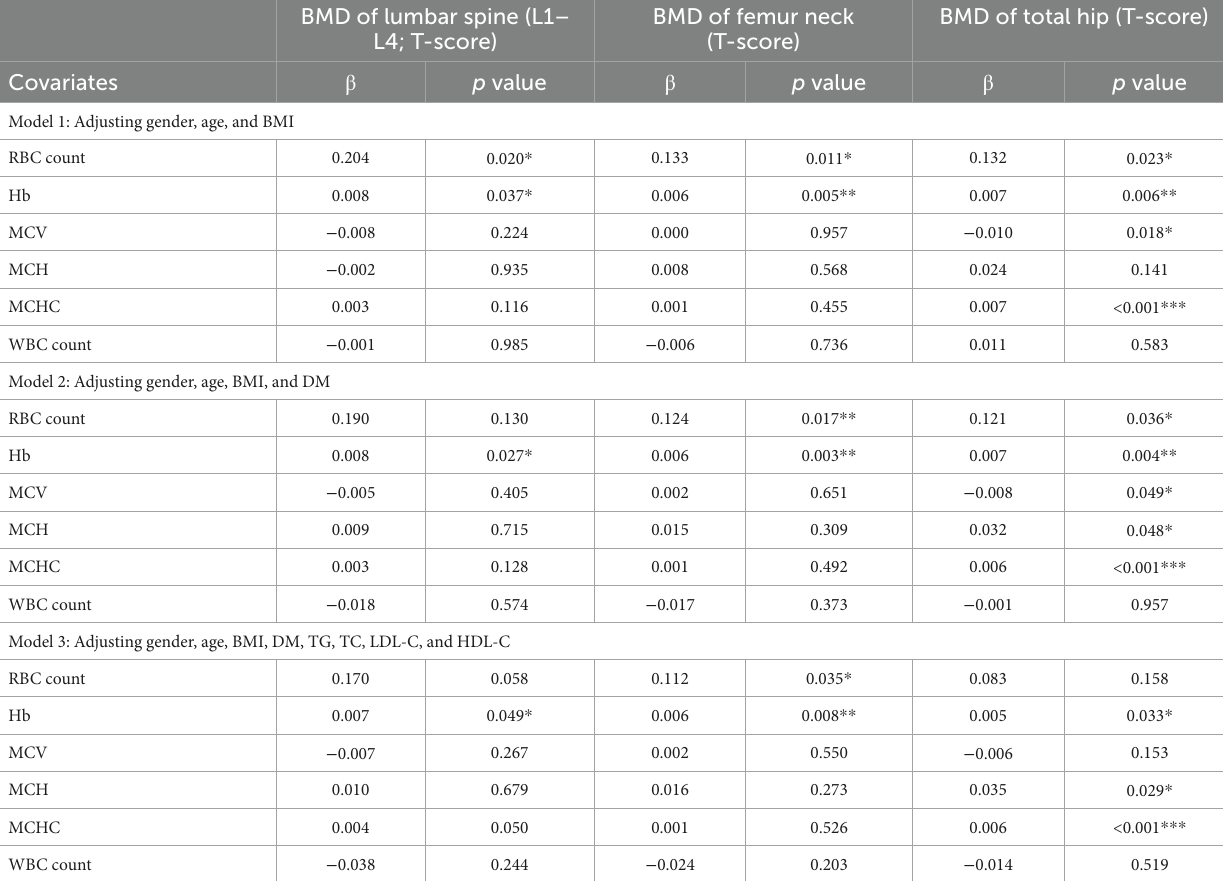
TABLE 3 Correlation between blood indices and BMD T-score at lumbar spine1-4, femur neck, and total hip. BMD of lumbar spine (L1– BMD of femur neck L4; T-score)